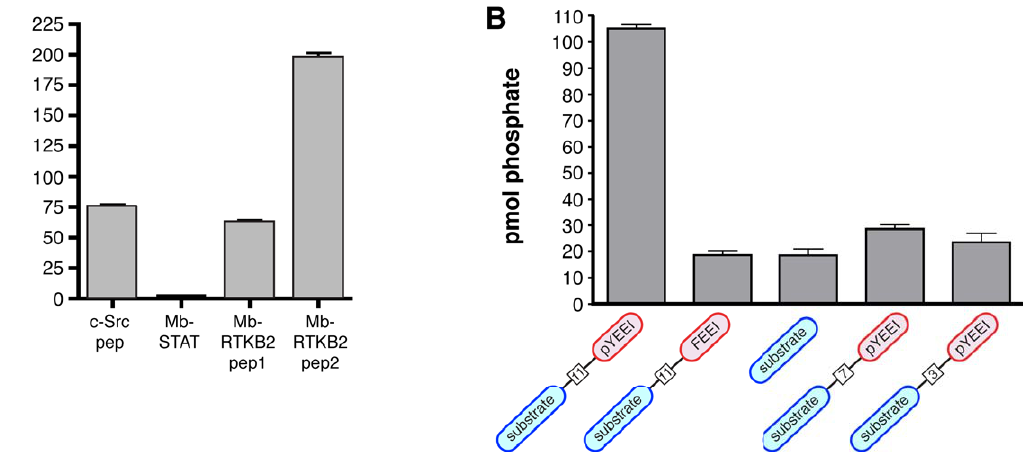
Figure 2. Additional HMTK1 peptide phosphorylation assays. Reactions proceeded for 6 minutes at 30 u C, and enzyme activity was measured using the phosphocellulose paper assay. (A) Phosphorylation of a c-Src peptide and Monosiga-derived peptides (750 m M) by purified HMTK1 (400 nM). The sequences are: c-Src peptide, AEEEIYGEFEAKKKG; MbSTAT peptide, KKKASGYVMADIA; RTKB2 peptide 1, SEEVYGAVVDKKK; RTKB2 peptide 2, AEEVYEAIADKKK. (B) Phosphorylation of SH2-binding substrates containing various spacer lengths between the pY residue and the phosphorylatable tyrosine. The peptides are shown schematically, with the phosphorylation site in blue, the SH2-binding ligand (pYEEI) in red, and the number of intervening amino acids in a box. The sequences of the peptides are: RRLEDAIYAAGGGGGEPPQpYEEIG (spacer=11), RRLEDAIYAAGEPPQpYEEIG (spacer=7), and RRLEDAIYAPQpYEEIG (spacer=3); SH2 control substrate, RRLEDAIYAAGGGGGEPPQFEEIG (spacer=11); substrate peptide, RRLEDIAYAAG. Reactions contained 70 m M peptides. Error bars show standard deviation.